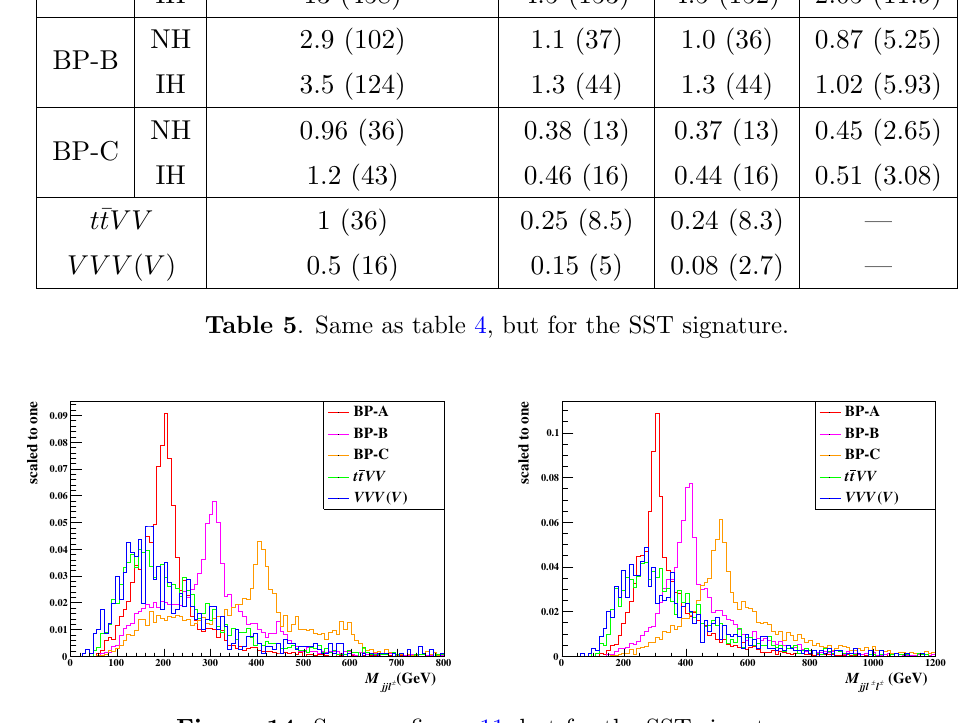
Figure 14 . Same as (cid:12)gure 11, but for the SST